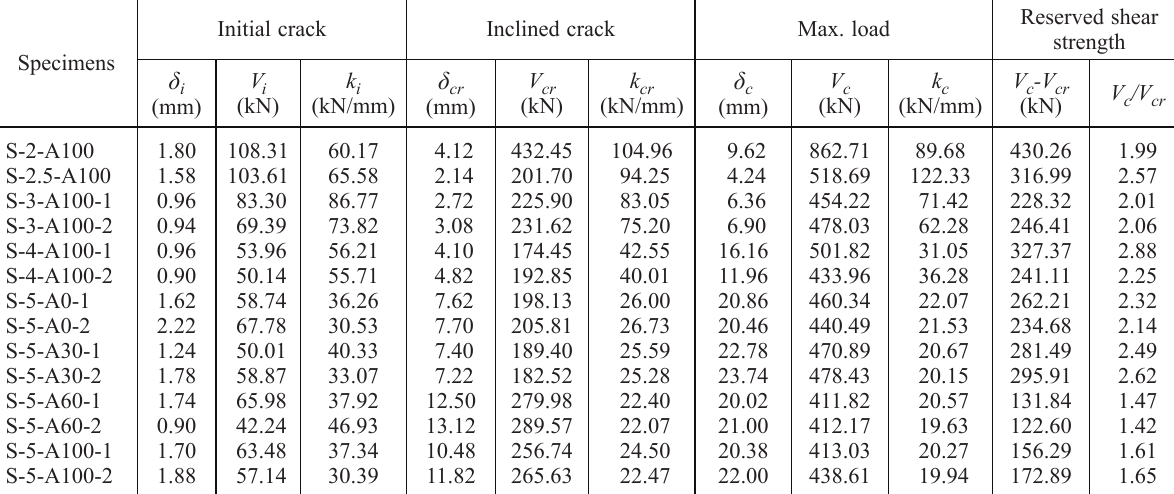
Table 5. Summary of test results for beam specimens